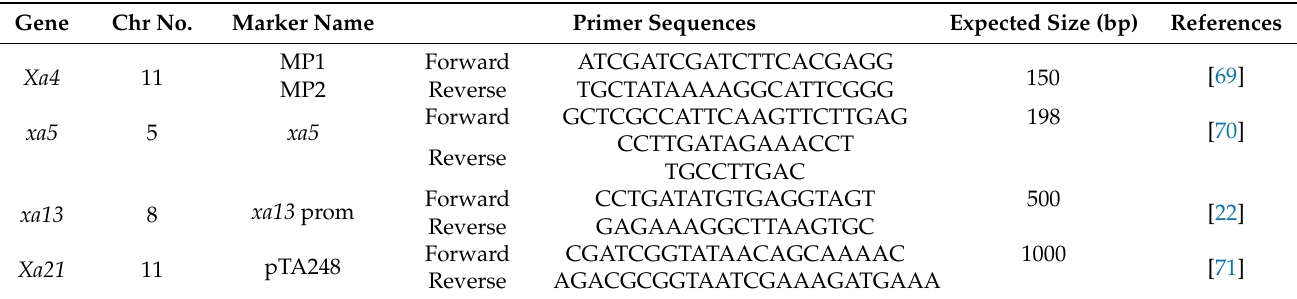
Table 6. Gene-specific DNA markers linked to BB resistance genes which were used in screening and selection of pyramided lines. Gene Chr